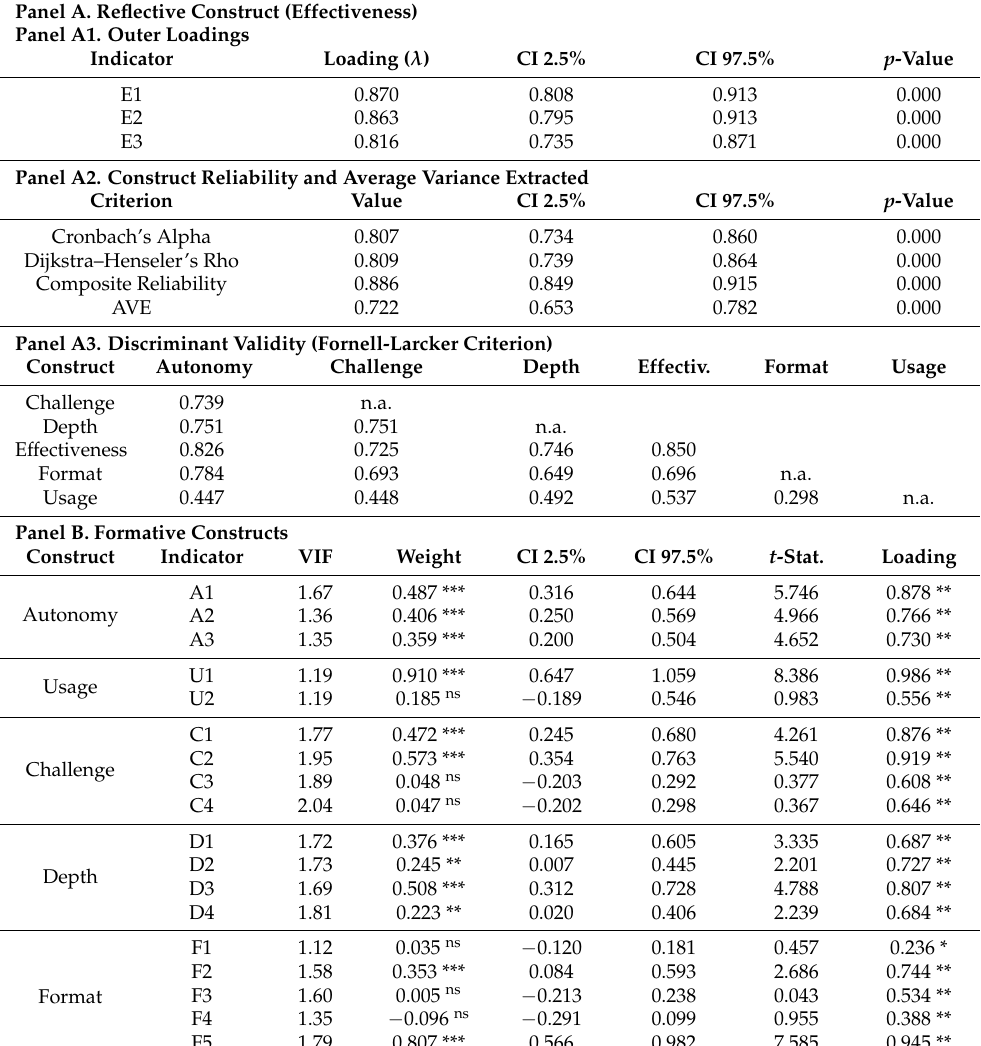
Table 4. Valuation of the Measurement